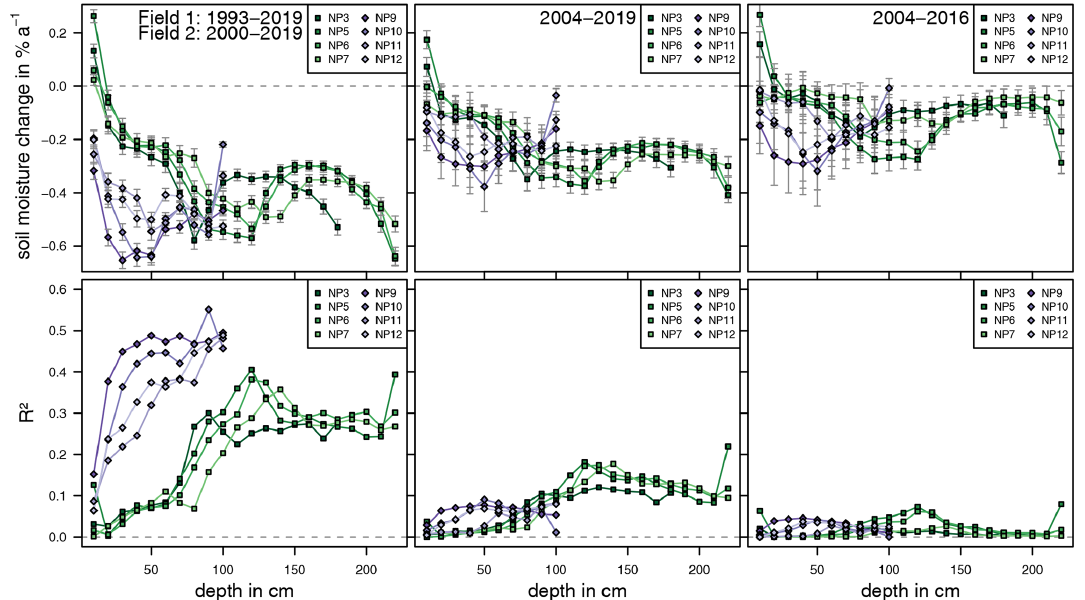
Figure A4. Results of individual linear regressions for soil moisture measurements in the recultivation layer, expressed as change in soil (cid:104) (cid:105) moisture content %a − 1